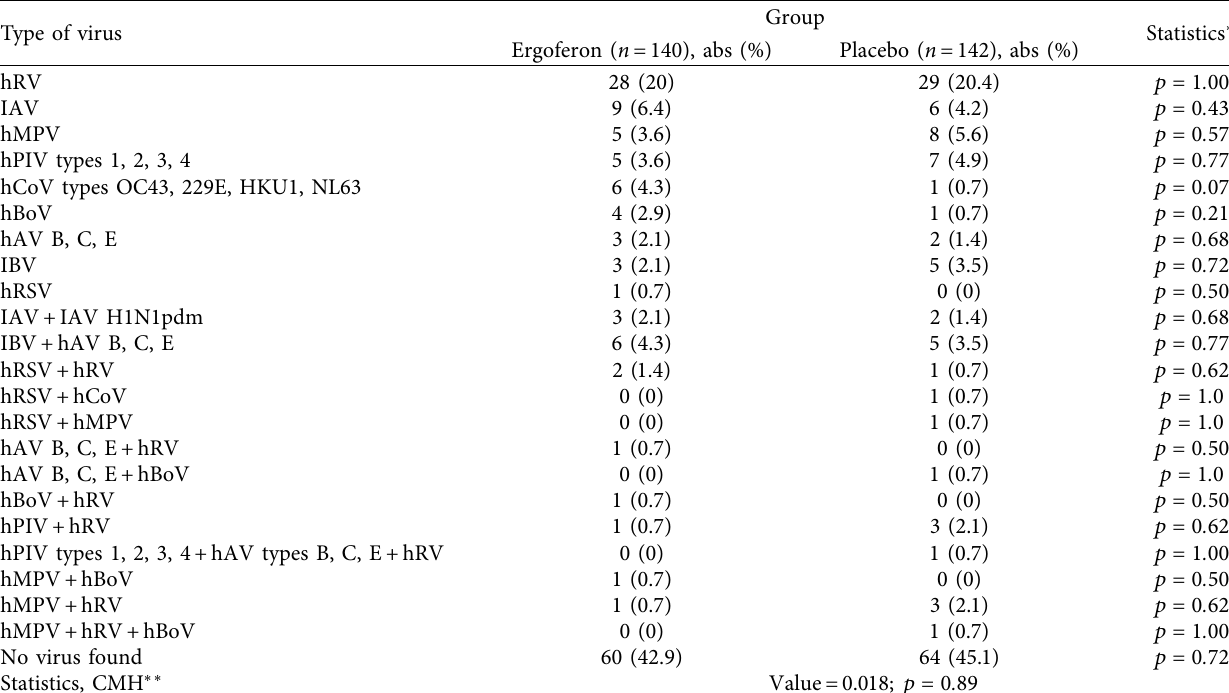
Table 2: Results of multiplex real-time RT-PCR assays of